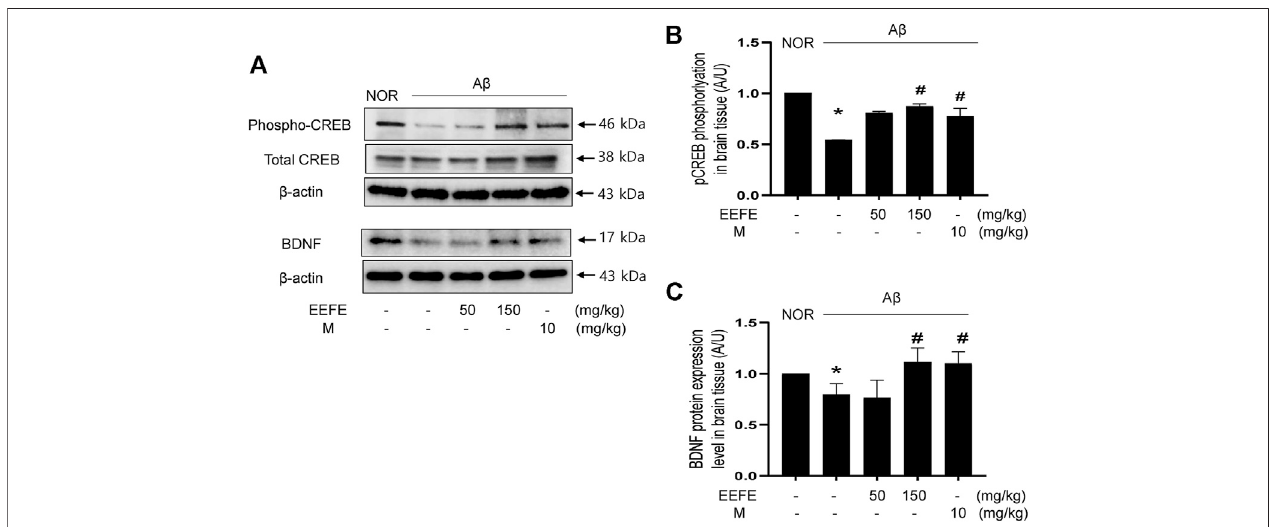
FIGURE 6 | Effects of EEFE on the CREB/BDNF signaling dysfunction in A β -injected mice. (A) Homogenized brain lysates were applied to western blot analysis. CREB phosphorylation and BDNF expression were detected with anti-phospho-CREB and BDNF antibodies. Images were visualized using a ChemiDox imaging analyzer. (B, C) Quantitative analysis was performed to assess the band intensities of phospho-CREB (B) and BDNF (C) in the western blotting. The protein levels were normalized to β -actin for BDNF and total CREB for phospho-CREB. The results are presented as the mean ± SD ( n (cid:1) 3/group). * p < 0.05 vs NOR group and # p < 0.05 vs A β group. A β , A β 1 – 42 – injected mice; EEFE, ethanol extracts of Ficus erecta ; M, morin; NOR: normal control mice.